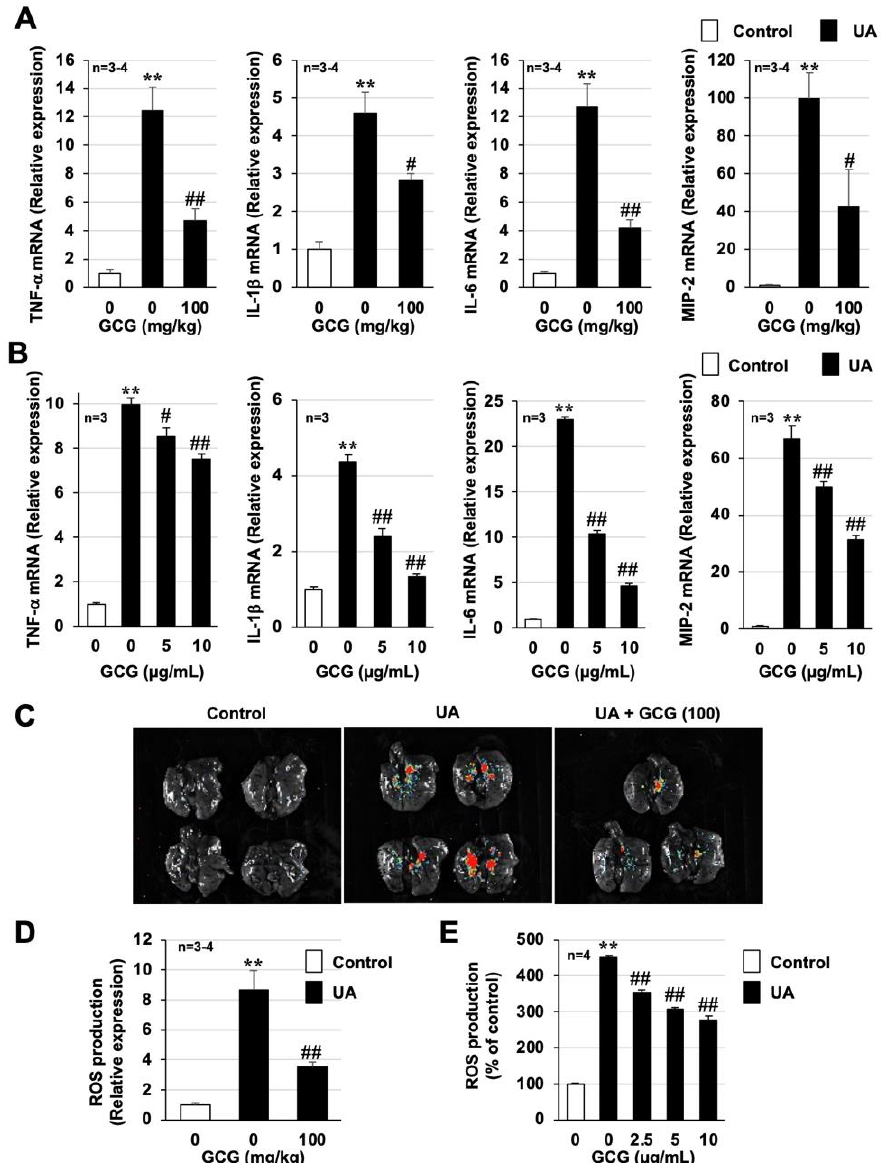
Figure 7. Effect of GCG on urban aerosol-induced ROS production and inflammatory responses . ( A , C , D ) Male ICR mice were intraperitoneally administered GCG (100 mg/kg in sterile saline) or sterile saline 1 h before intratracheal administration of urban aerosol particle suspension (1.0 mg/mouse) or sterile saline (Control). ( A ) Total RNA was extracted from the lungs 24 h after administration of urban aerosol particle suspension and subjected to real-time RT-PCR using a specific primer set for each gene. Values were normalized to Gapdh and are expressed relative to the Control. ( C ) Luminescent probe (L-012, 75 mg/kg) was administered 24 h after administration of the urban aerosol particle suspension. Isolated lungs were imaged using a FUSION chemiluminescence imaging system. ( D ) The summed pixel intensity of the ROS signal was determined using standard FUSION software. ( B , E ) RAW264 cells were treated with GCG (5–10 or 2.5–10 µ g/mL) prior to the addition of urban aerosols (30 µ g/cm 2 ) to the medium. ( B ) Total RNA was extracted from the RAW264 cells 24 h after the addition of urban aerosols and subjected to real-time RT-PCR using a specific primer set for each gene. Values were normalized to Gapdh and are expressed relative to the Control. ( E ) The cells were precultured with H 2 DCFDA (10 µ M) for 60 min prior to GCG and urban aerosol treatment. After 24 h, the ROS levels were measured using a microplate reader. Values represent the mean ± SEM; # p < 0.05; ** or ## p < 0.01. ( # vs. UA).